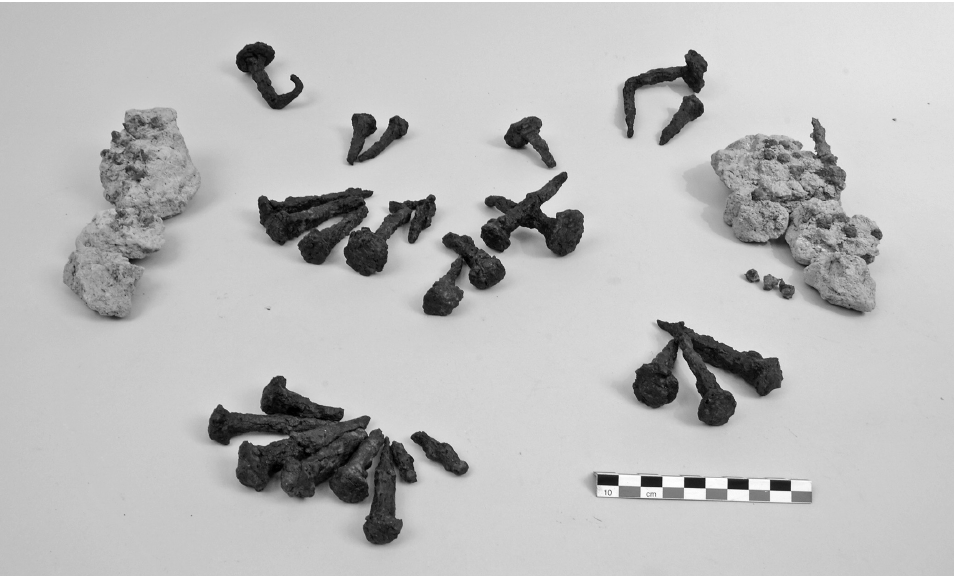
Figure 5: Acqui Terme, tomb no. 3. Nails and caligae (photo Melania Cazzulo © Soprintendenza Archeologia del